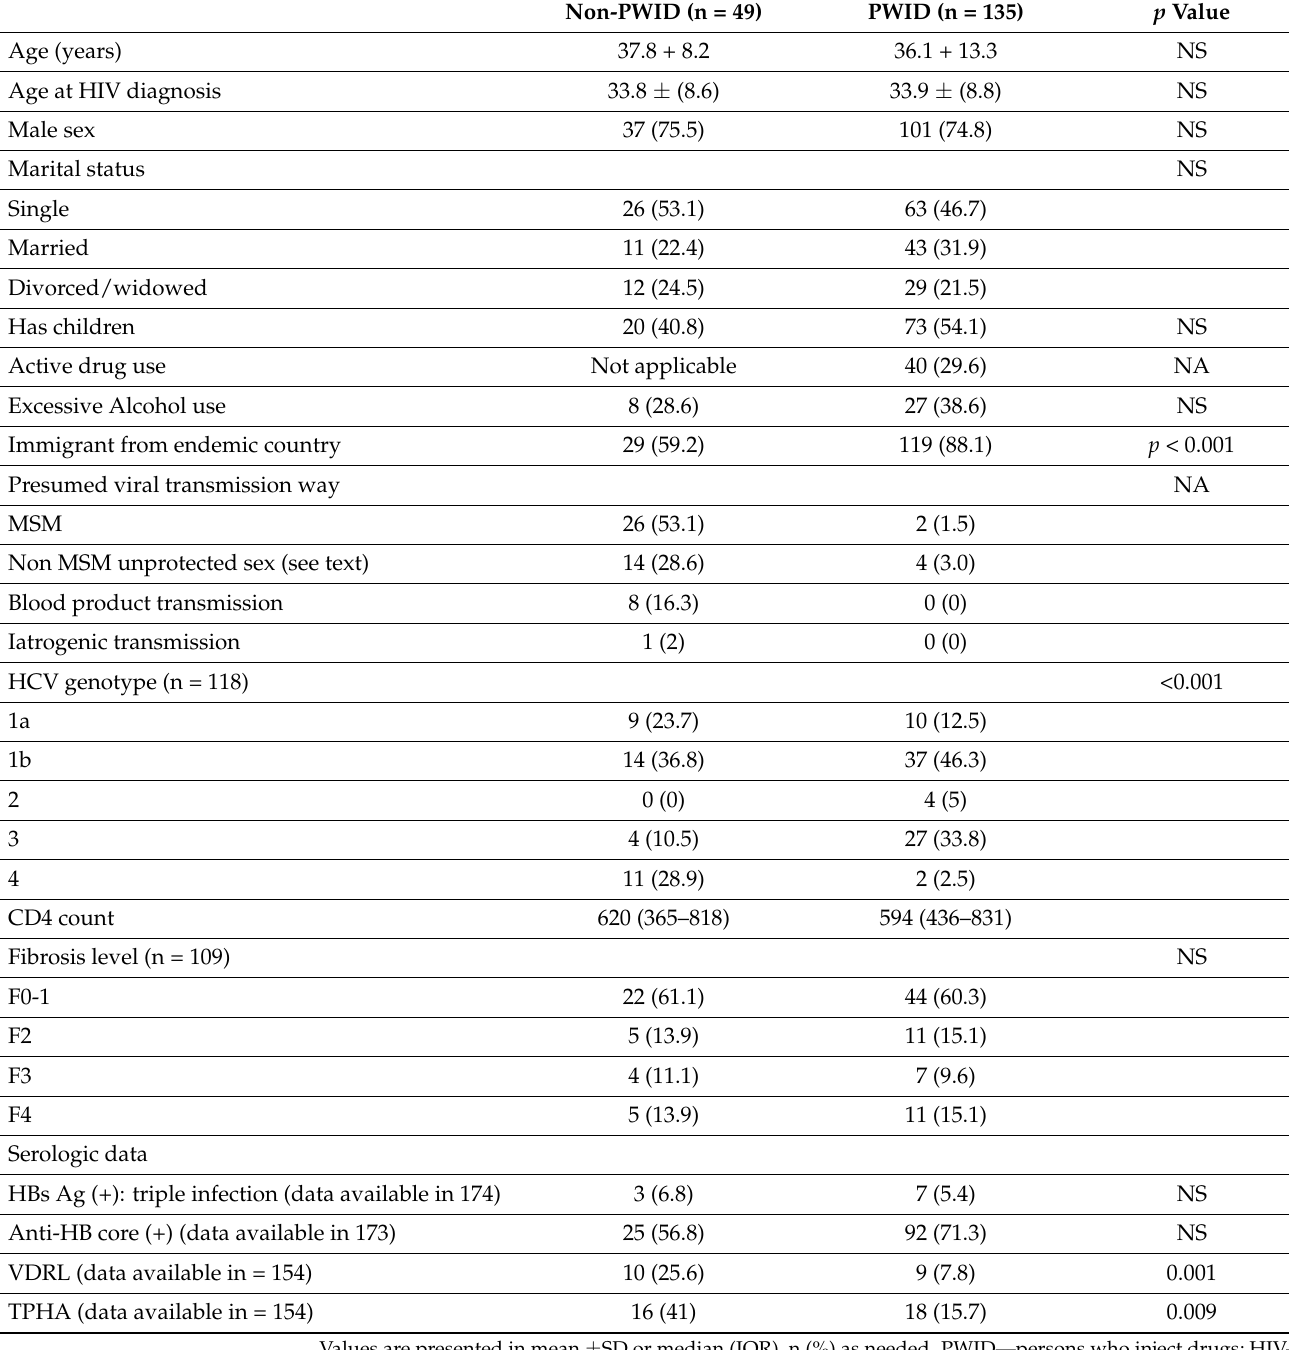
Table 2. Comparison of the basic characteristics of two study